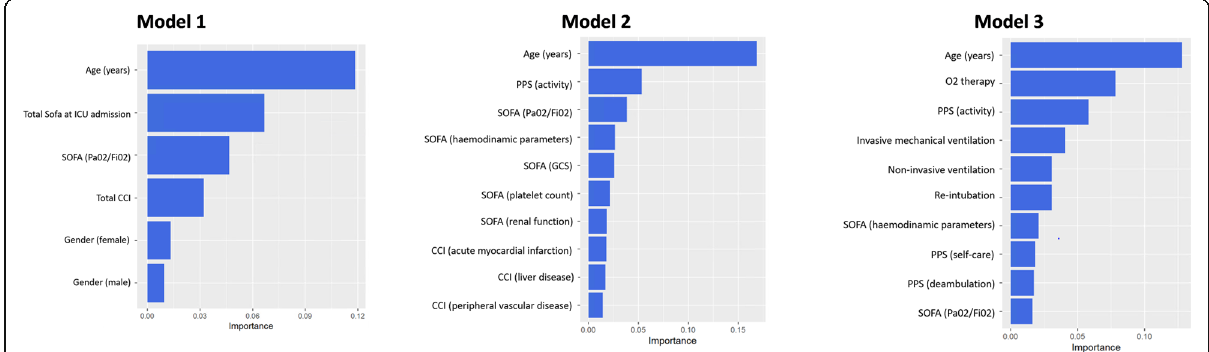
Fig. 3 Variable importance plots. The ten most important predictors are reported in the plots. Abbreviations: PaO 2 /FiO 2 , arterial partial pressure of oxygen to inspired oxygen fraction ratio; SOFA, Sequential Organ Failure Assessment; CCI, Charlson Comorbidity Index; GCS, Glasgow Coma Scale; PPS, Palliative Performance